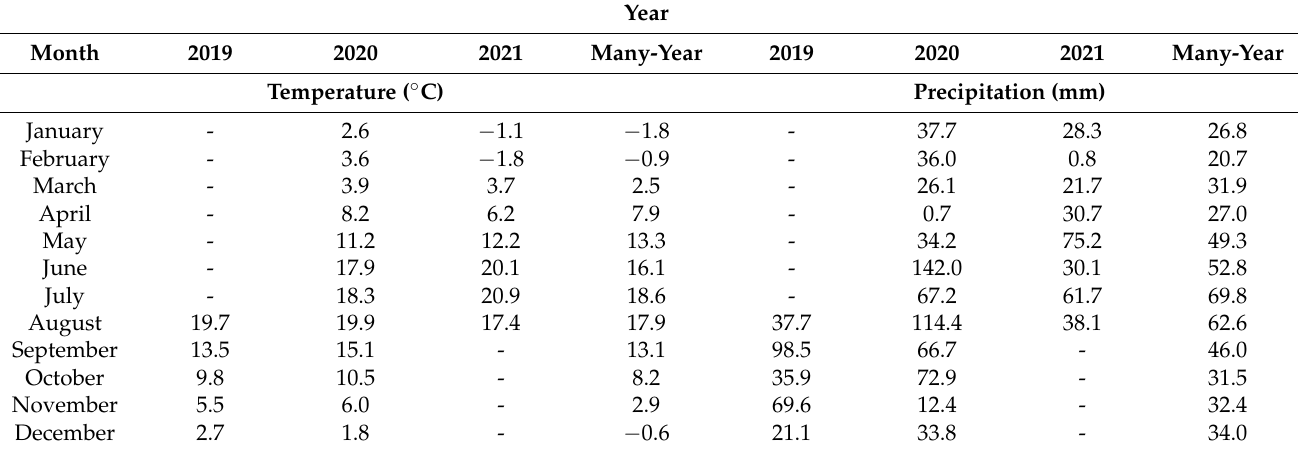
Table 2. Air temperature and precipitation during the field experiments